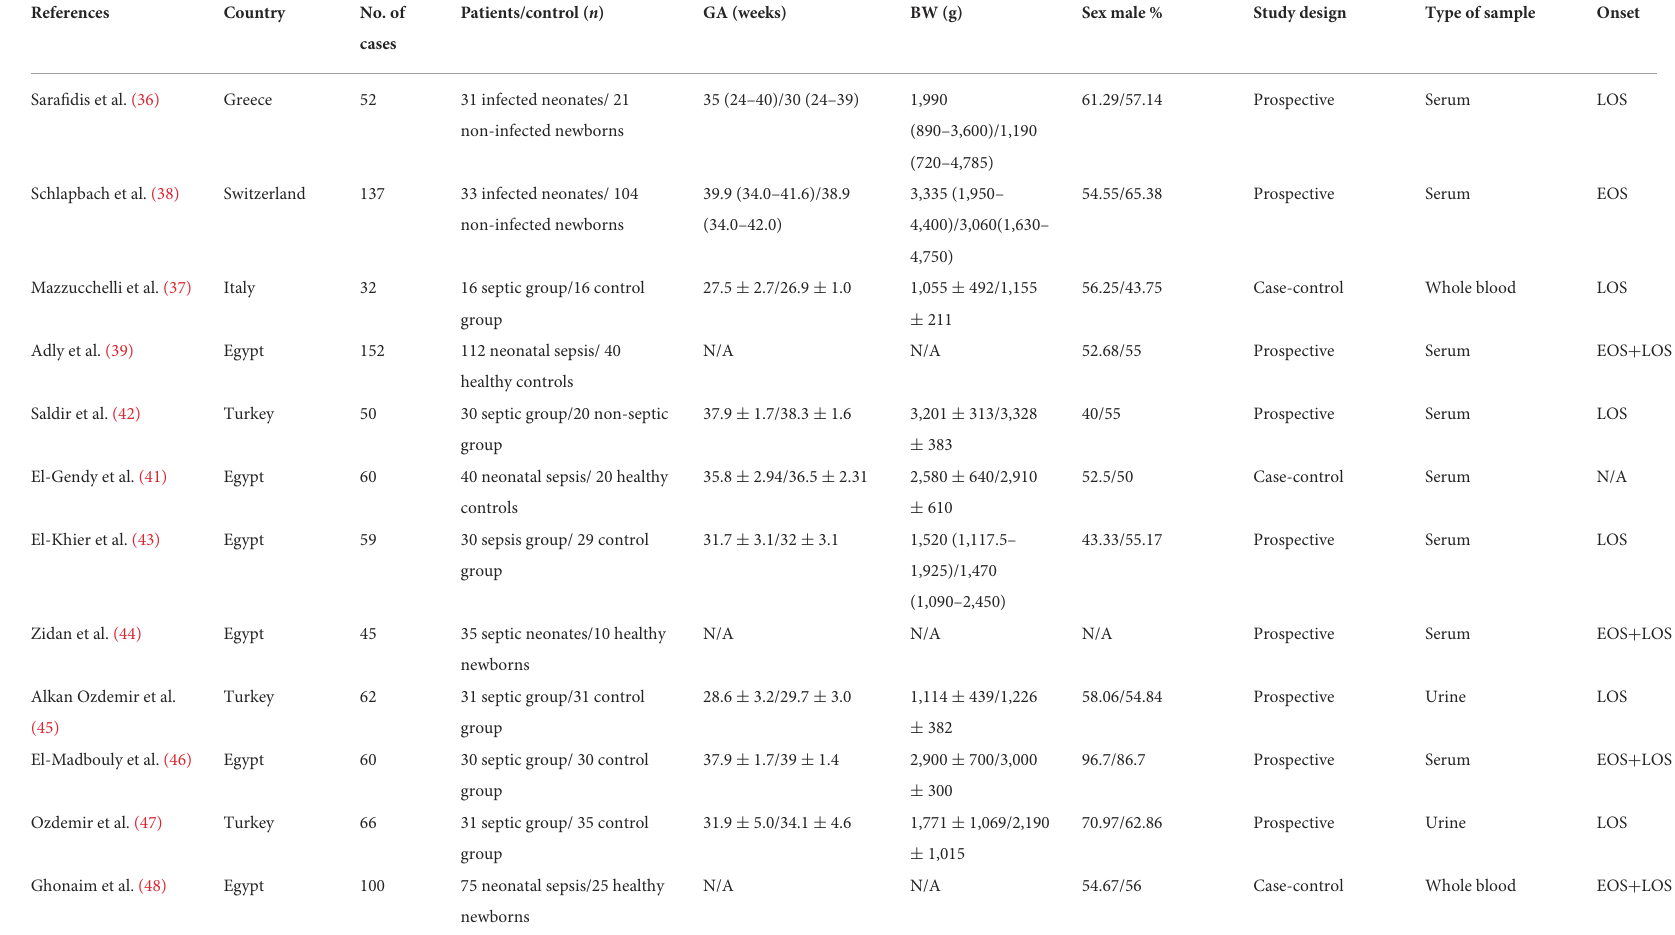
TABLE 1 Characteristics of the included studies that investigated the diagnostic value of TREM-1 expression in neonatal